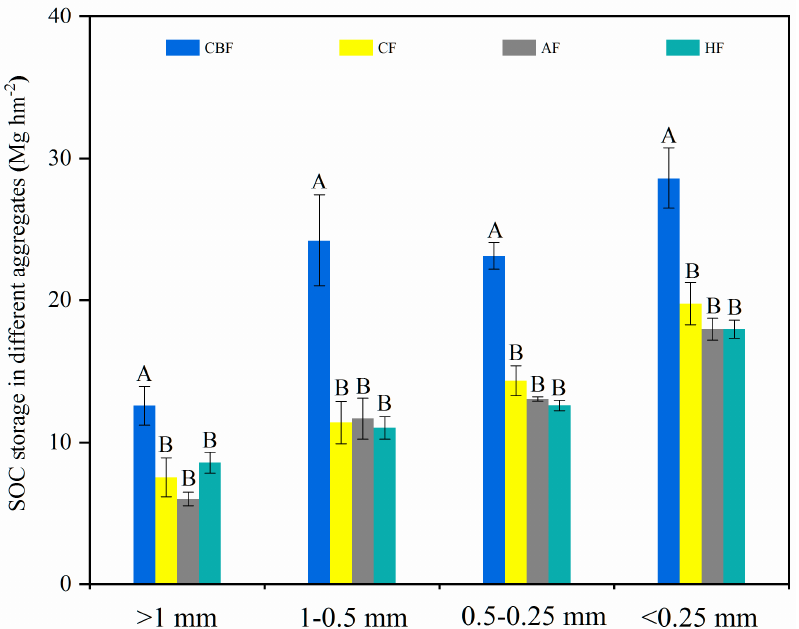
Figure 3. SOC storage for each aggregate fraction in the different forest types. Note: The different capital letters indicate significant differences in the same aggregate size among different forest types ( p < 0.05). Values are expressed as means ± standard errors.